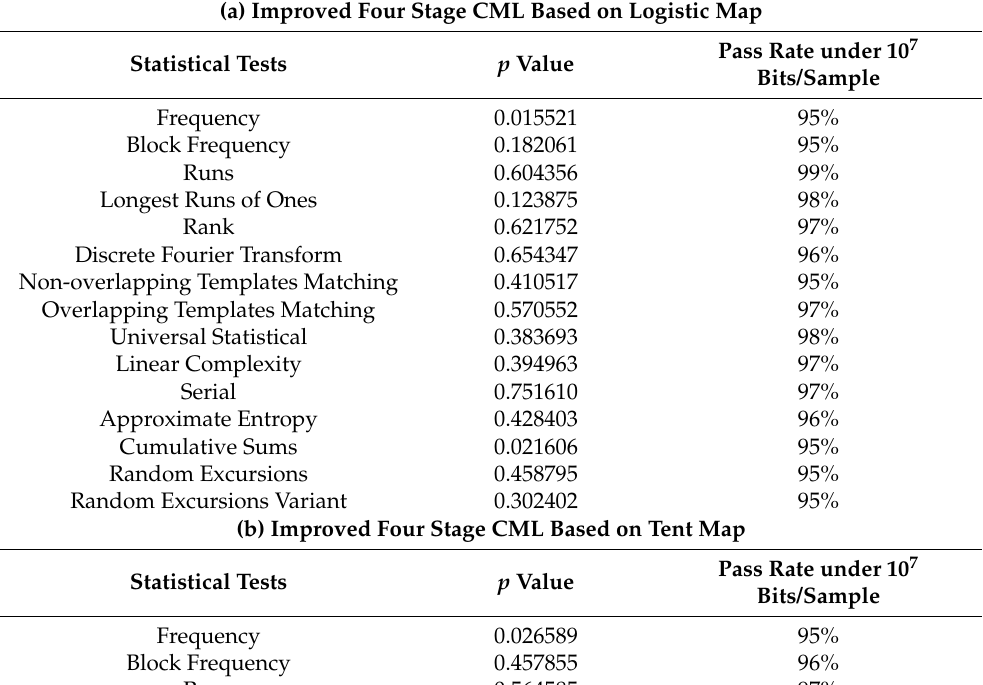
Table 4. Statistical test results of the proposed improved CML under NIST SP800-22. (a) Improved Four Stage CML Based on Logistic